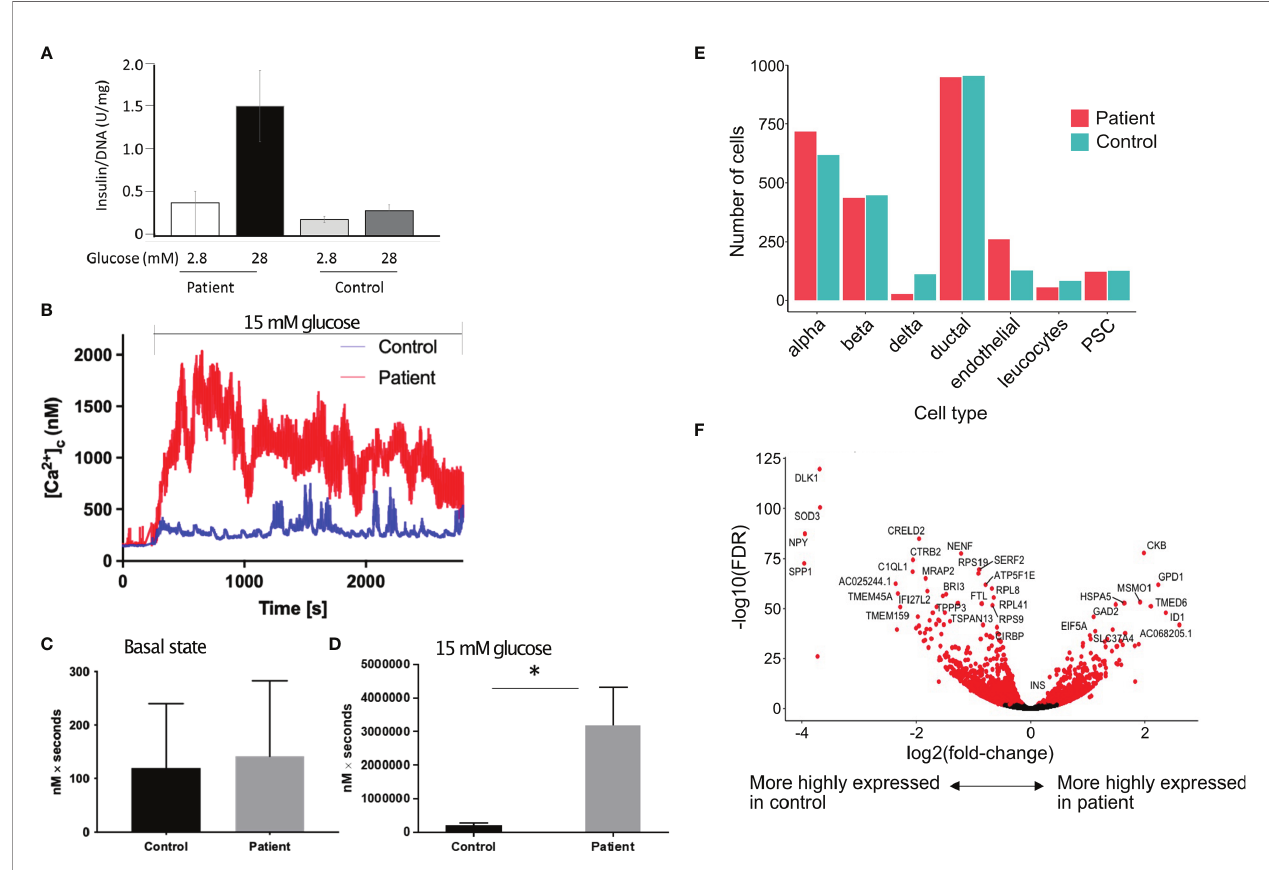
FIGURE 2 | Increased insulin secretion by the islets. (A) In vitro glucose stimulated insulin secretion of isolated islets cells. Data show mean ± SD of 3 replicates. (B) Increase in cytoplasmic calcium level (which triggers degranulation of insulin granules) in response to 15 mM glucose in patient ’ s islets (red) as compared to control islets (blue). (C, D) Area under the curve (expressed as nM x seconds) of cytoplasmic calcium in islets in the basal state (C) and during stimulation with 15 mM of glucose (D). Data show mean ± SD of 3 replicates. *p=0.0289, 2 tailed unpaired t test. (E) Proportion of different cell types in the islets from the patient as compared to a single control using 10X single cell sequencing. (F) Volcano plot showing differentially expressed genes in the b cells of patient ’ s islets as compared to control